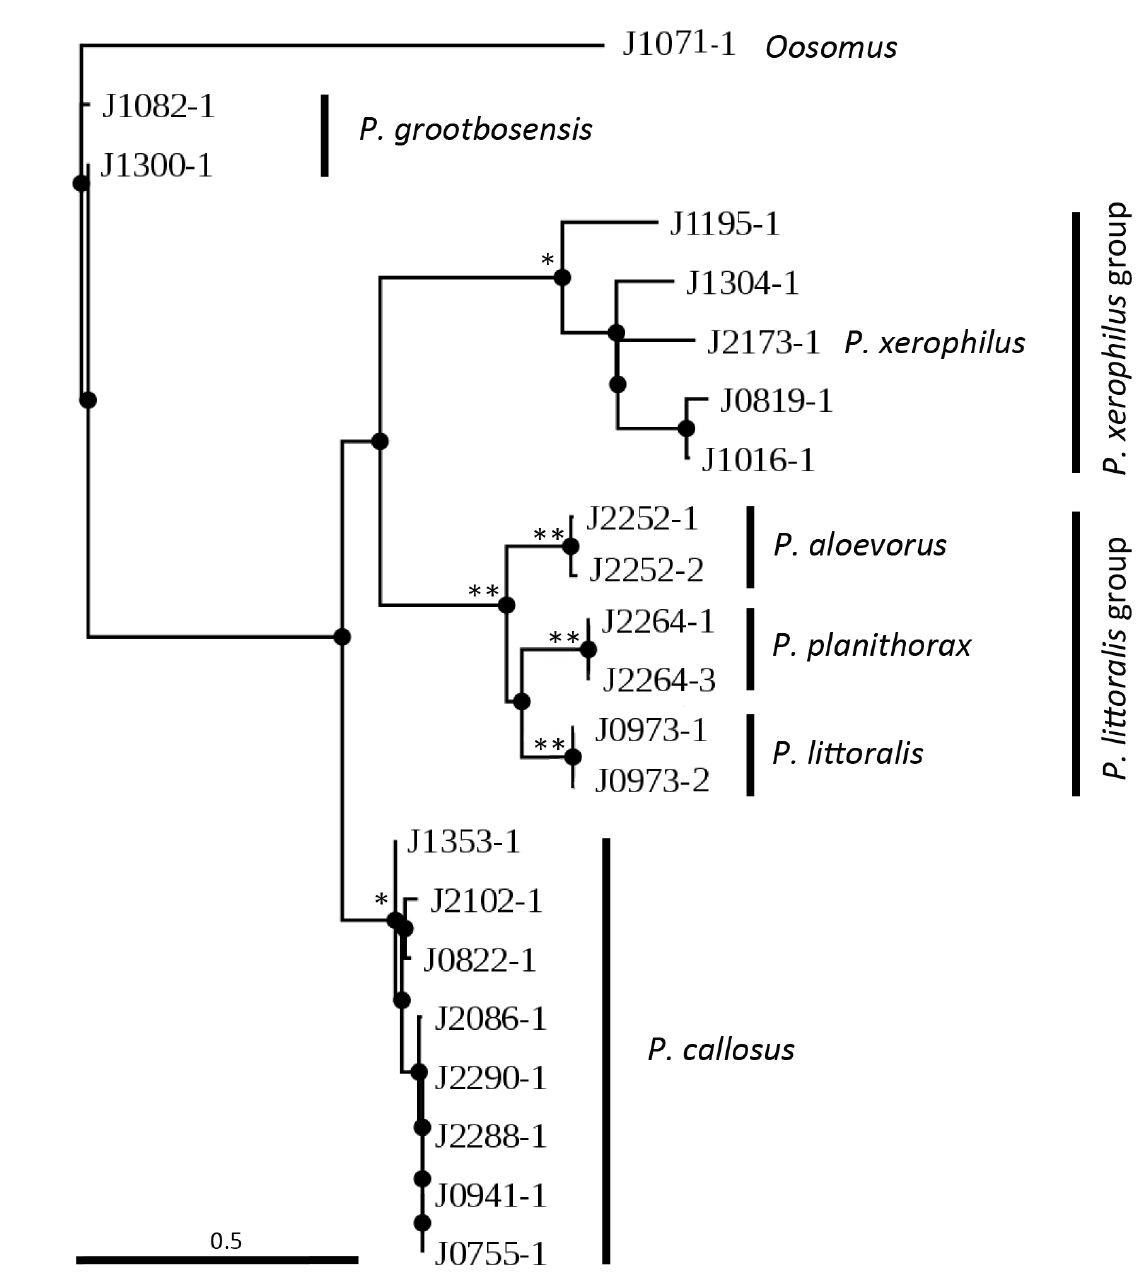
Fig. 5. PhyML tree of Phlyctinus Schoenherr, 1826 species inferred from mitochondrial Cytochrome oxidase I ( COI , 658 base pairs). Bootstrap support values as obtained from 1000 replicates (*above 80, ** above 95). Specimens codes were shortened for representation: JHAr0 = J and _0101 =